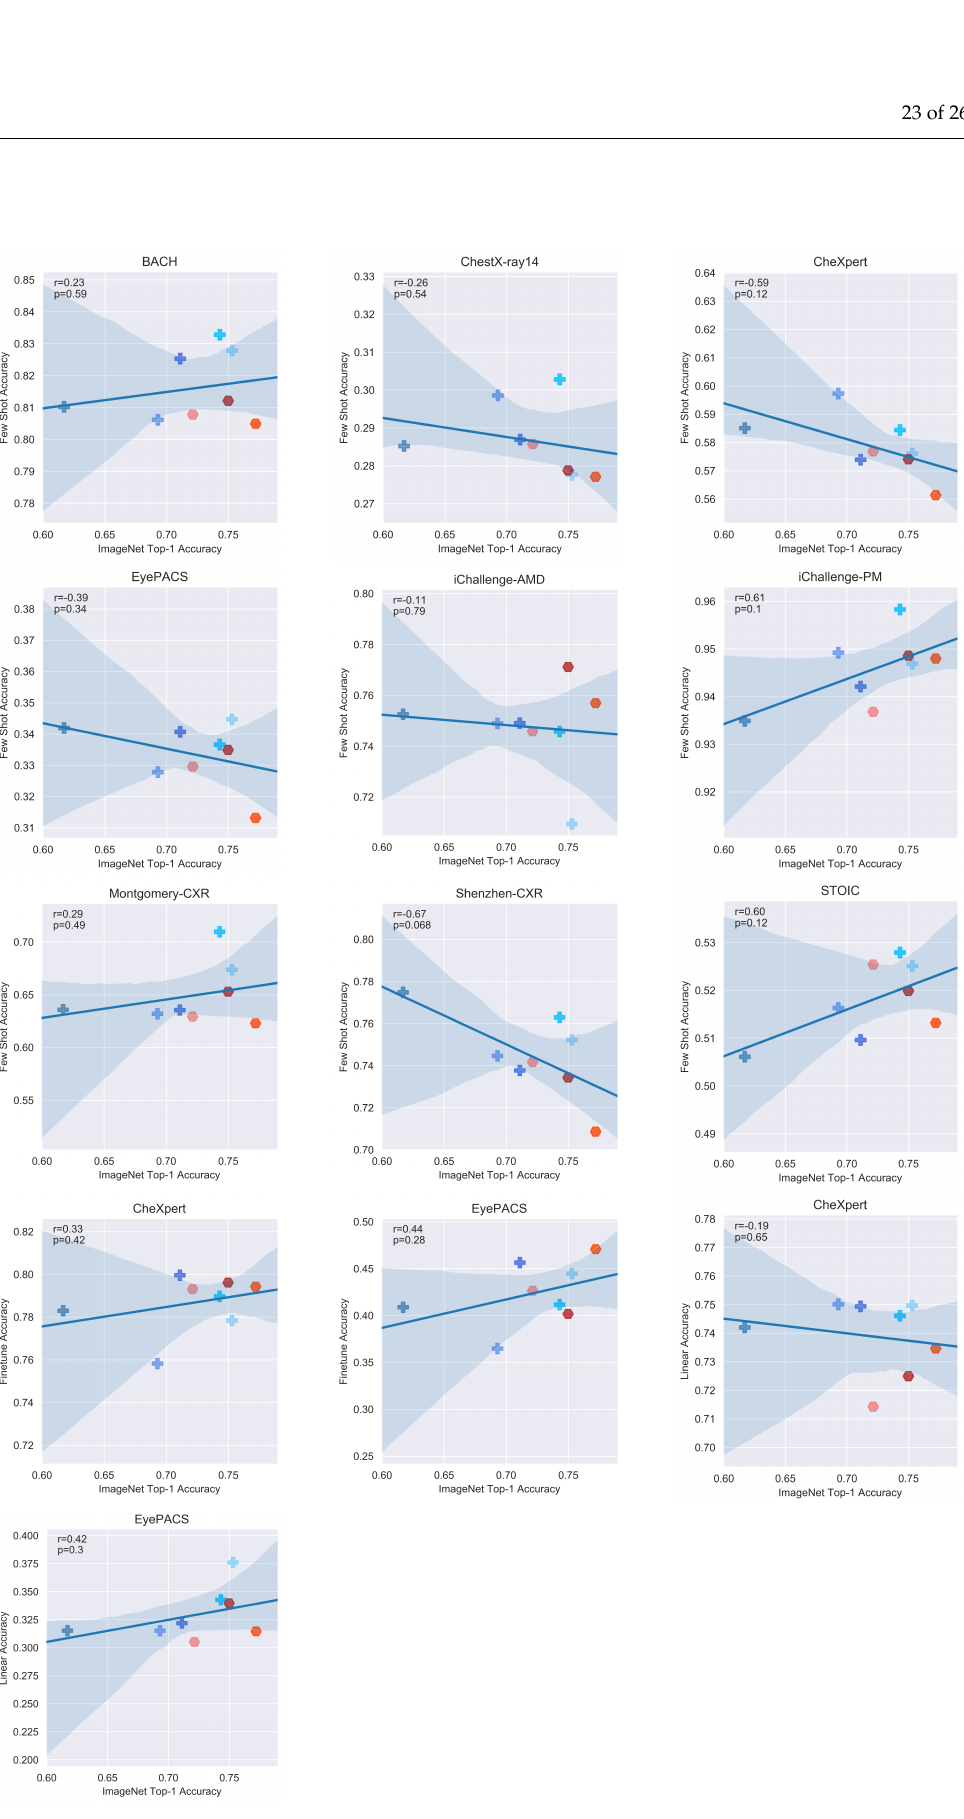
Figure A4. ImageNet top-1 accuracies plotted against transfer performance. Shown overlaid are the Pearson’s r correlation coefficients and associated p values.